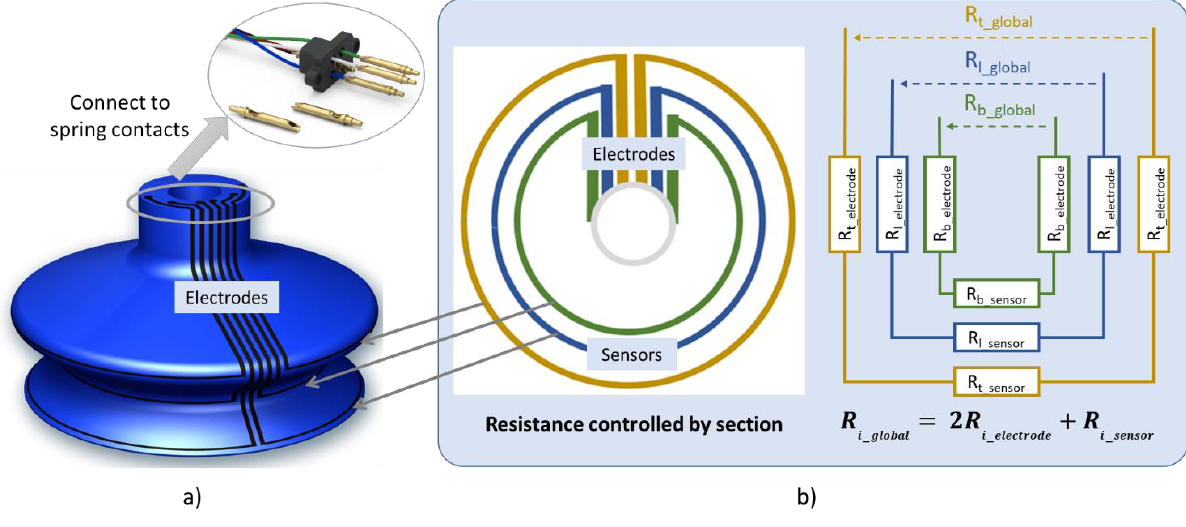
Figure 2. Design of sensor coating: ( a ) prototype consisting of 3 printed circle-shaped sensors coated on the lip, top, and bottom bellows; ( b ) equivalent resistance defined by different zones.